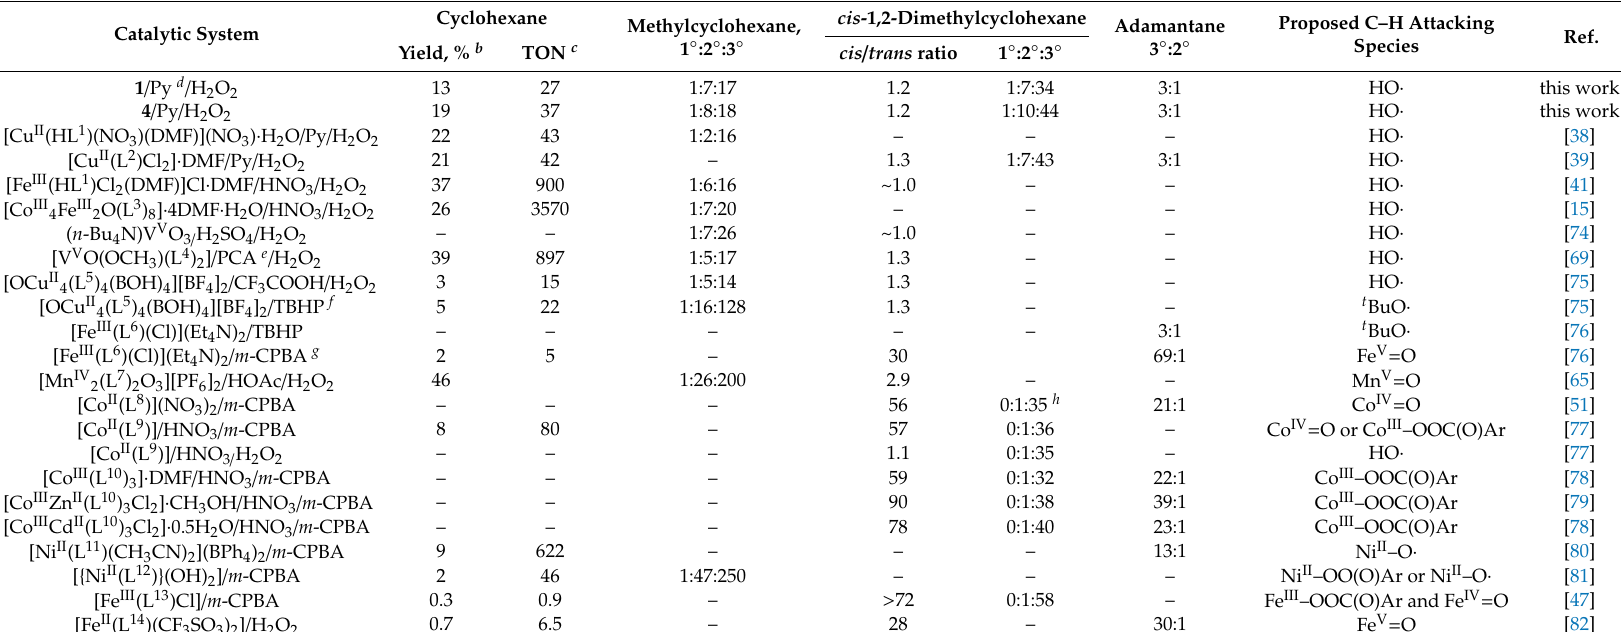
a Parameters 1 ◦ :2 ◦ :3 ◦ (for methylcyclohexane and cis -1,2-dimethylcyclohexane) and 3 ◦ :2 ◦ (for adamantane) are normalized bond selectivities, corrected for the numbers of respective hydrogen atoms. The cis / trans ratio is the ratio of the tertiary alcohols having methyl groups in cis and trans positions, respectively. b Yield of products (cyclohexanol and cyclohexanone) based on the substrate. c turnover numbers, mols of products per mol of catalyst. d Pyridine. e Pyrazinearboxylic acid. f Tert -butylhydroperoxide. g Meta -chloroperoxybenzoic acid. h Zero value means that the primary alcohol was not detected or its amount is not reported. HL 1 = product of condensation of salicylaldehyde and 1-(2-aminoethyl)piperazine; HL 2 = product of condensation of 2-pyridinecarbaldehyde and aminoguanidine; H